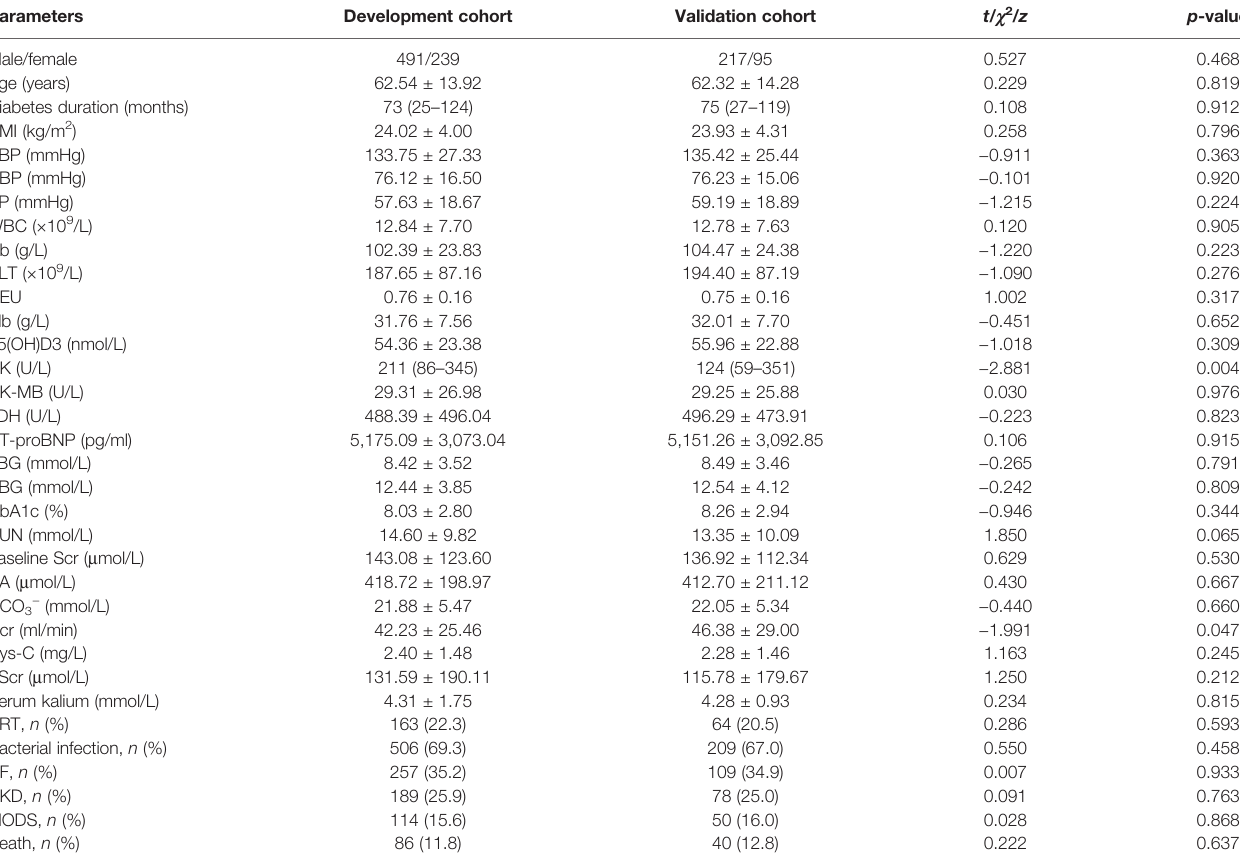
TABLE 1 | Differences in the development cohort and the validation cohort in terms of demographic characteristics and laboratory values.